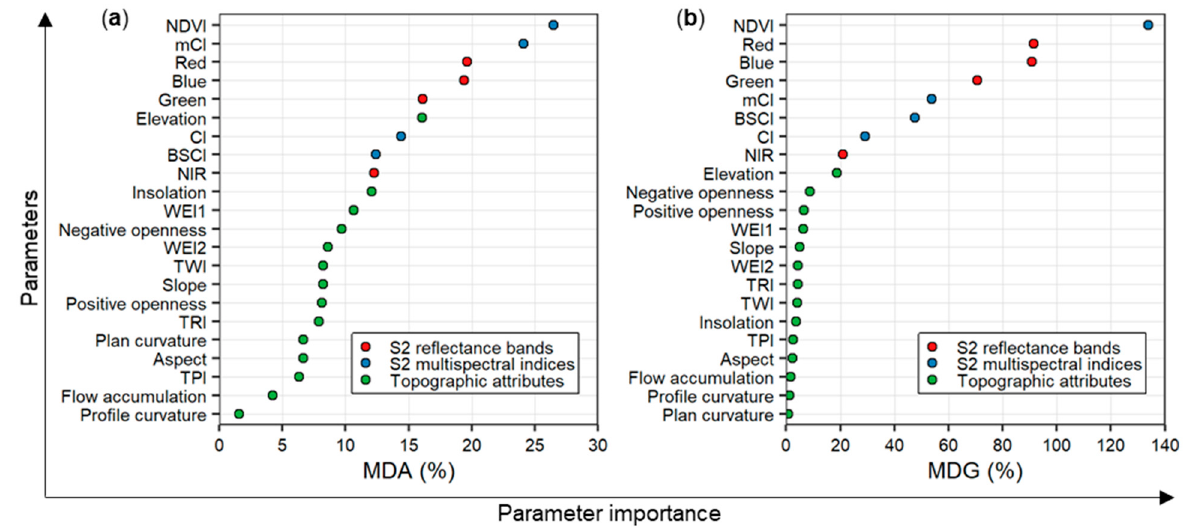
Figure 5. All parameters, i.e., Sentinel-2 (S2)-based reflectance bands, multispectral indices and topographic attributes (TAs), as incorporated into the Random Forest (RF) classification model, ranked by their importance depicted by the mean decrease in accuracy (MDA), measuring how much accuracy is lost in percent when the respective variable is permuted from the model ( a ) and the mean decrease in Gini coefficient (MDG), measuring how much each variable contributes to the homogeneity of the nodes in the resulting RF model ( b ). Explanations of the acronyms of the individual TAs can be found in Table 2.